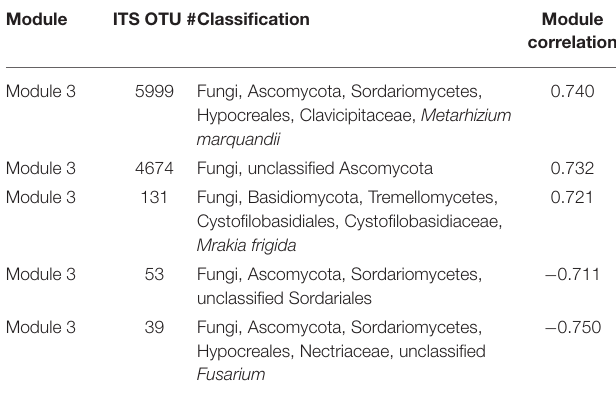
TABLE 3 | ITS hub taxa by